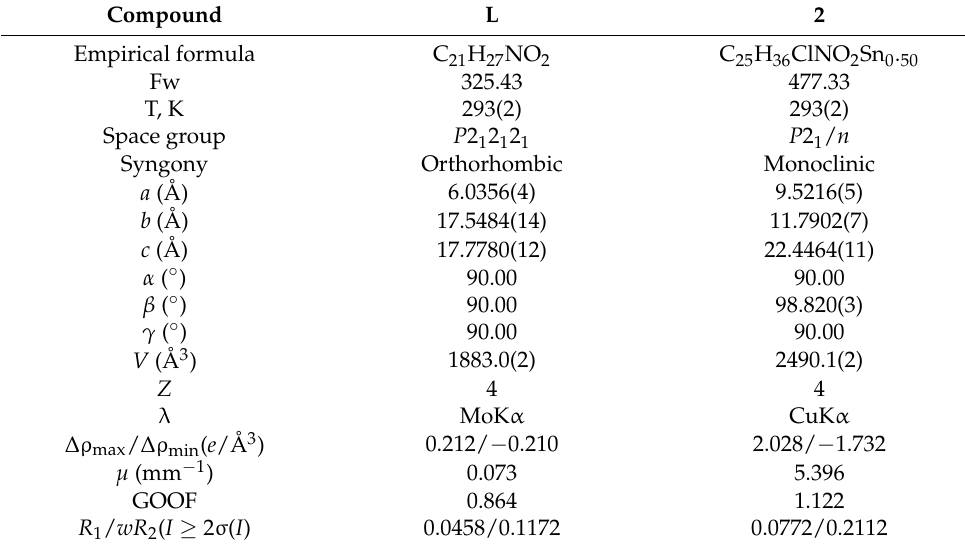
Table 1. Crystal data and the structure refinement details for compounds L and 2 .